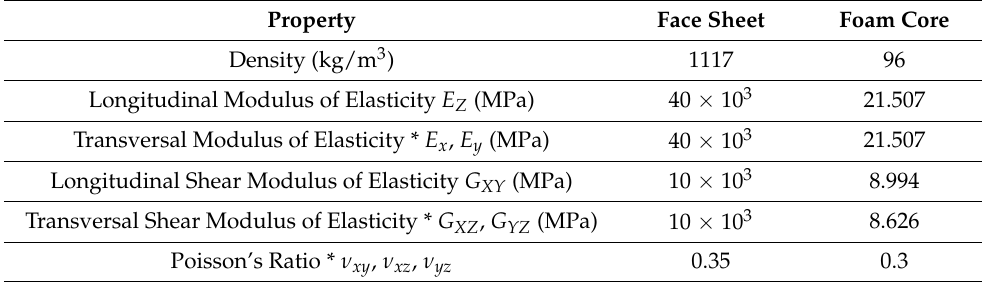
Table 1. Material property values used in FEA.